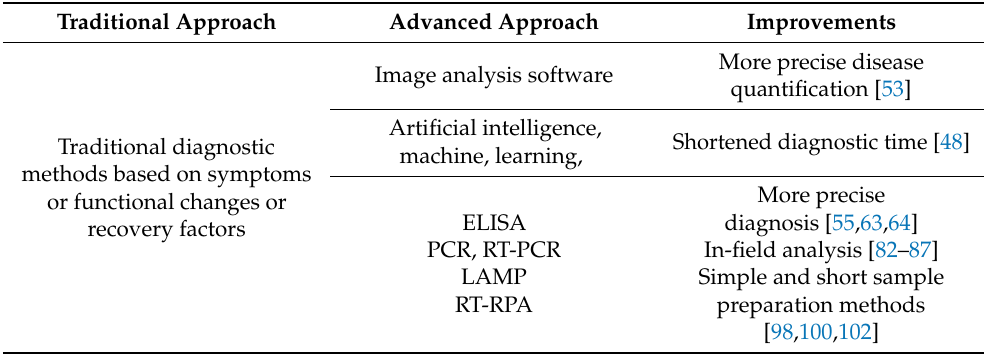
Table 2. Tools adopted for fruit and foliar disease diagnosis, according to the traditional approach, and possible improvements provided by a more advanced, digital-based